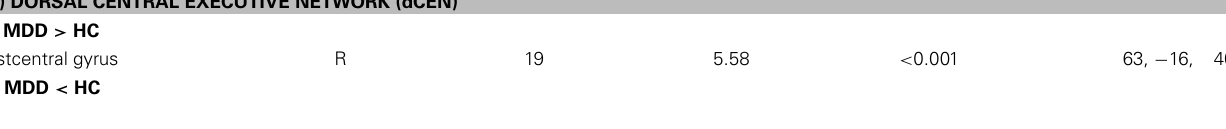
( Figure 5 , Table 7 ; p < 0 . 05, partial correlations with age, sex and GM of the brain areas covered by the 7 networks of interest as covariates of no-interest, Bonferroni-corrected for